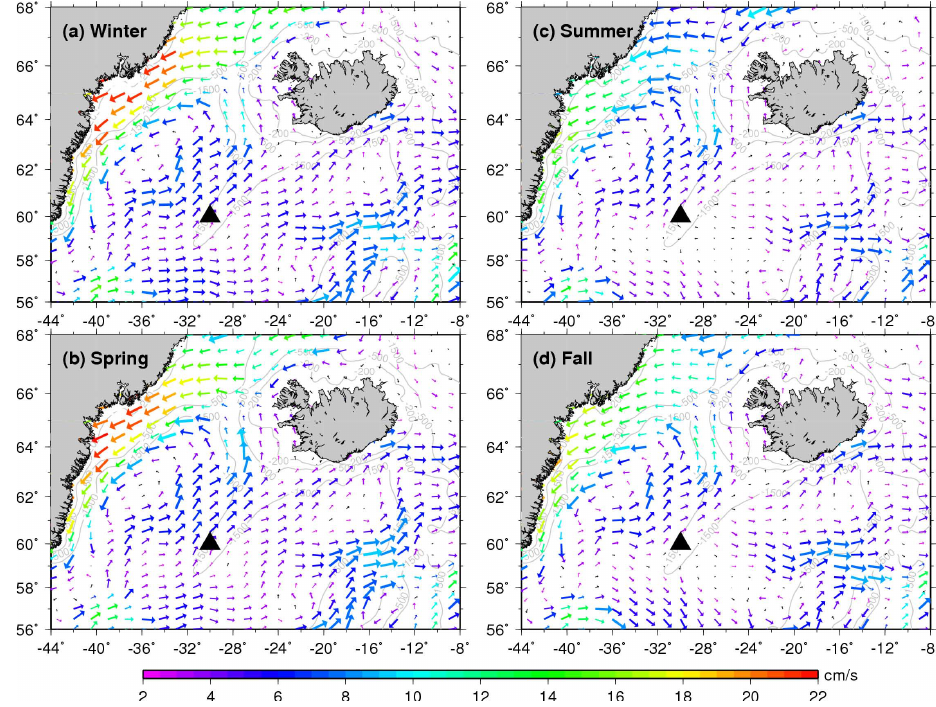
Fig. 3. Map showing the 3-D model seasonal climatologic (1955–2008) surface currents and the location of the 1-D ecosystem model simulations (black triangle).